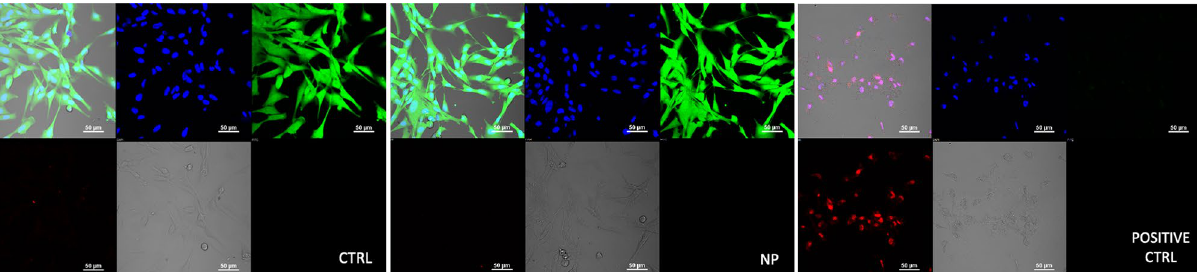
Figure 8. LIVE/DEAD assay in SAF cultured for 24 h with or without NP 0,625 ppm. A cell viability assay was used with SAF cultures for simultaneous fluorescence staining of viable cells (Calcein-AM, green fluorescence) and dead cells (Propidium Iodide PI, red fluorescence). The total cell number was evaluated using the viable nucleic acid staining Hoechst 33,342 (blue fluorescence). Confocal microscopy was used for image acquisition. As shown in images, both in CTRL and in NP 0,625 ppm groups, cells emit a bright green fluorescence. On the contrary, in POSITIVE CTRL, cells did not show any green fluorescence while nuclei emit red fluorescence. CTRL: SAF fibroblast cultured for 24 h without NP; NP: SAF cultured for 24 h with NP at the concentration of 0,625 ppm; POSITIVE CTRL: a sample of SAF cultured for 24 h in presence of very high/cytotoxic concentration (12,5 ppm) of NP was used as a positive